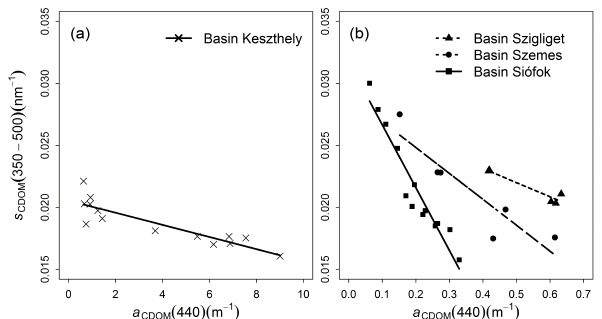
Figure 3. Plot of S CDOM (350–500) as a function of a CDOM (440) using the seasonal sampling data for (a) basin Keszthely, S CDOM (350–500) = − 0 . 0005 · a CDOM (440) + 0.0205, R 2 = 0 . 7833, p< 0 . 001 and (b) basin Szigliget, S CDOM (350–500) = − 0 . 0114 · a + 0.0277, R 2 = 0 . 9122, p = 0 . 011; basin CDOM (440) Szemes, S CDOM (350–500) = − 0 . 0209 · a CDOM (440) + 0.0209, R 2 = 0 . 7932, p = 0 . 0108 and basin Siófok, S CDOM (350–500) = − 0 . 0507 · a + 0.0317, R 2 = 0 . 9154, p< 0 . CDOM (440)